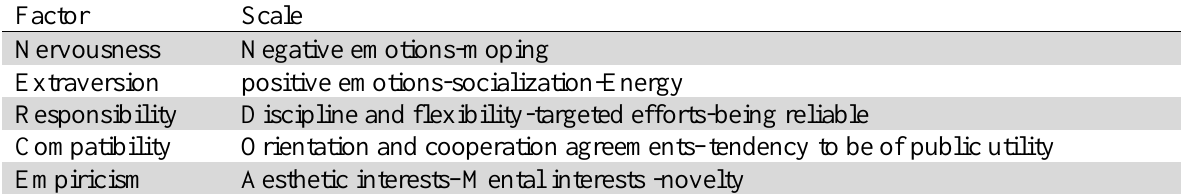
Five main factors of